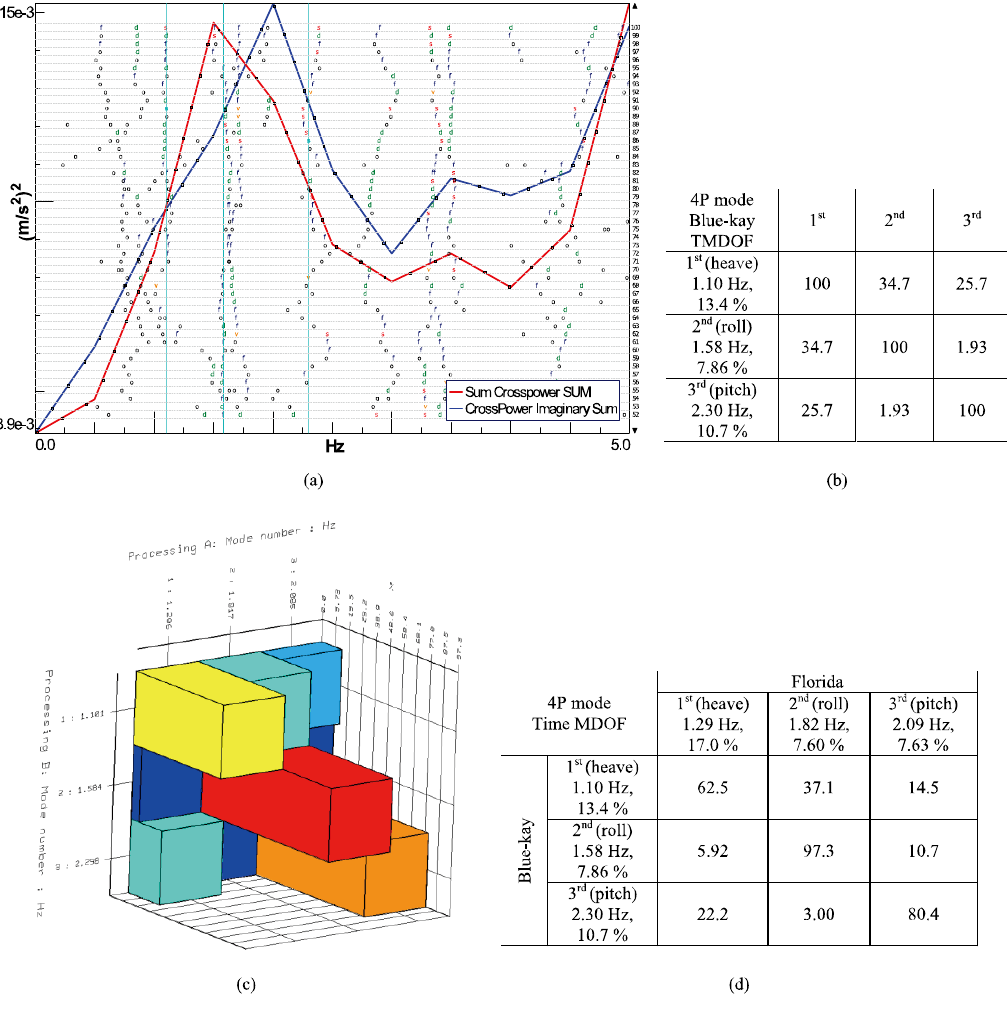
Fig. 5. Semi-active susp. car, four poster tests: TMDOF stabilisation diagram (a) and autoMAC table (b) in the Blue-kay case. MAC matrix (c) and table (d) between Blue-kay and Florida mode set TMDOF estimates.